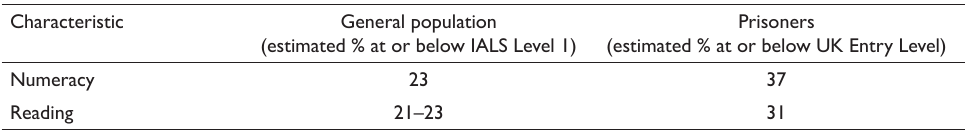
Table 1: Prisonersandgeneralpopulationbasicskillscomparison